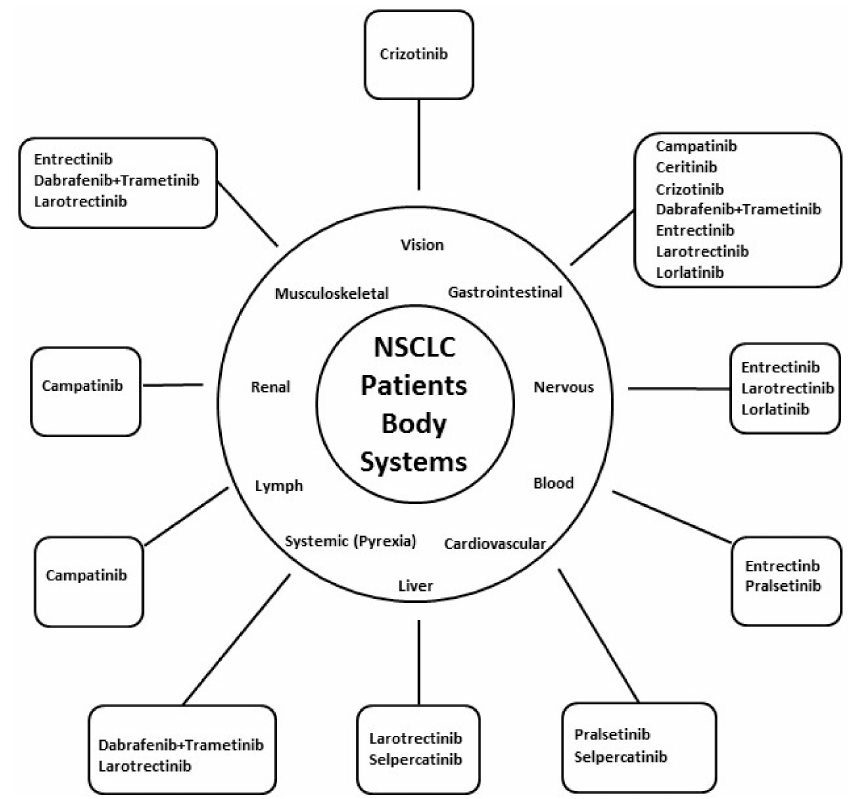
Figure 2. Common targeted therapies’ adverse events, categorized by systems. The figure shows the main targeted therapies causing adverse events in each of the main body systems. Clockwise: The main targeted therapy causing visual impairment is Crizotinib. Capmatinib, Ceritinib, Crizotinib, Dabrafenib + Trametinib, Entrectinib, Larotrectinib and Lorlatinib—cause Gastrointestinal adverse events. Entrectinib, Larotrectinib and Lorlatinib may cause neurological adverse events. Entrectinib and Pralsetinib are the most common causes of cytopenia. Pralsetinib and Selpercatinib could cause cardiovascular adverse events. The main causes of liver toxicity are Larotrectinib and Selpercatinib. Larotrectinib and the combination of Dabrafenib and Trametinib can cause Pyrexia. Capmatinib is the most common cause of lymphadenopathy. Capmatinib is the most common targeted therapy to cause renal toxicity. Entrectinib, Dabrafenib and trametinib and Larotrectinib may cause musculoskeletal adverse